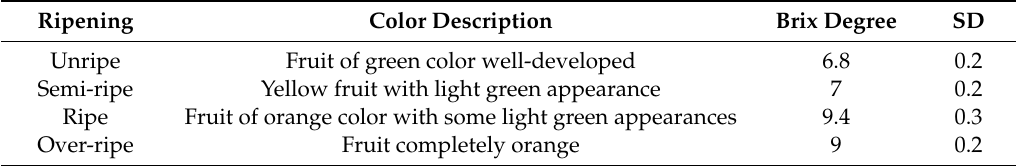
Figure 4. Color definition for the ripening stages of the Valencia orange based on NTC (Colombian Technical standard) 4086. Table 1. Ripening stage description and Brix degrees for Valencia orange (SD means standard deviation).